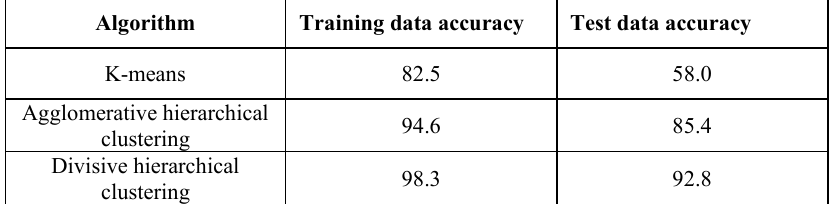
Table 3. Accuracy levels obtained through different